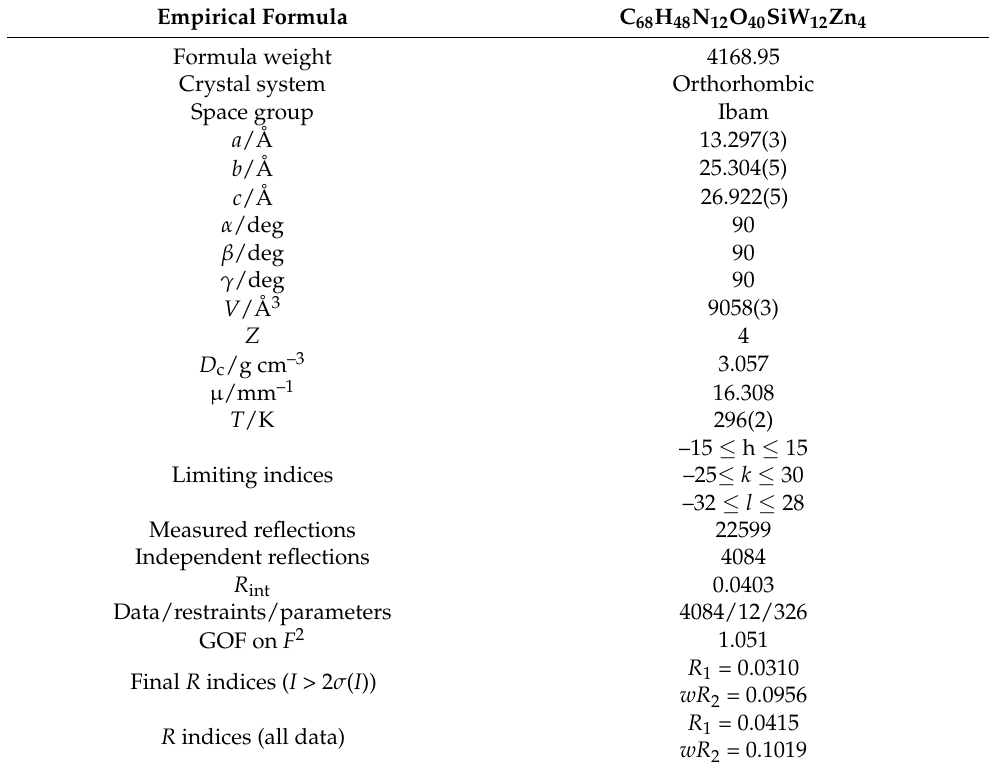
Table 1. Crystallographic data and structural refinements for